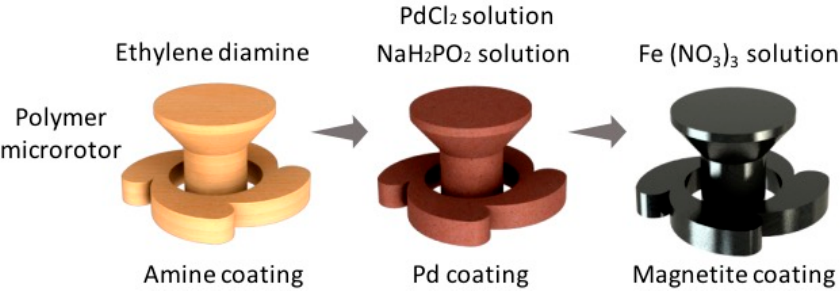
Figure 1. Electroless magnetite plating of a polymeric microrotor produced by two-photon microfabrication. Magnetite deposition on a polymeric microstructure can be realized through amine coating, Pd coating, and magnetite coating.